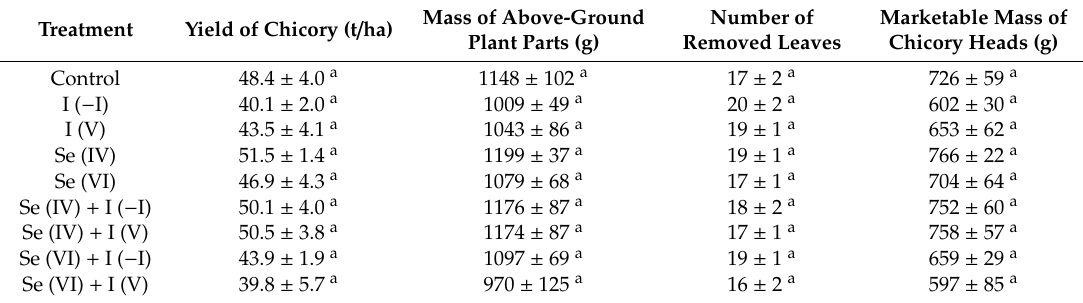
Mass of Above-Ground Number of Marketable Mass of Plant Parts (g) Removed Leaves Chicory Heads (g)